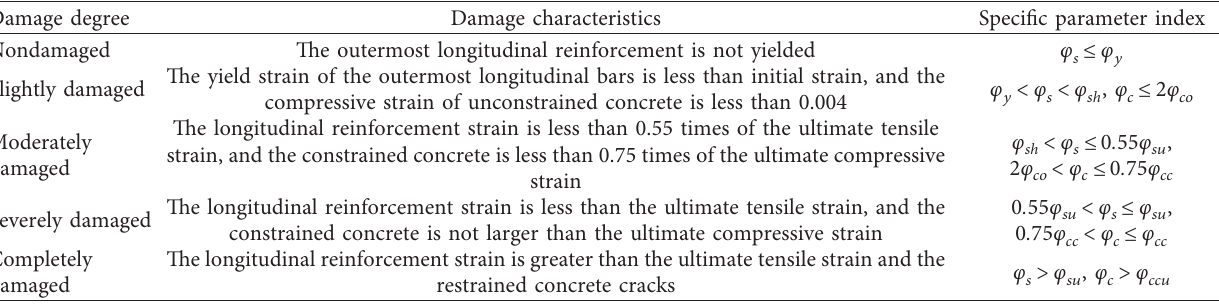
Table 1: Characteristics of curvature ductility